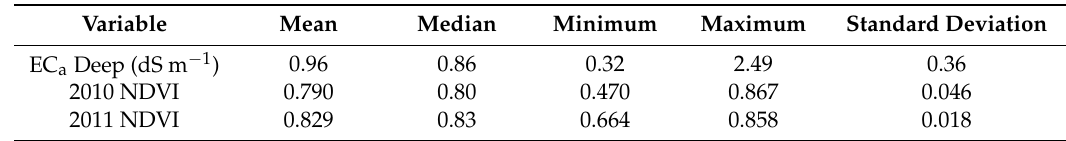
Figure 4. Maps of: ( a ) apparent electrical conductivity of the 0–1.5-m soil profile (EC a Deep); Normalized Difference Vegetation Index (NDVI) for ( b ) 2010 and ( e ) 2011; local geographically-weighted regressions (GWRs) slope coefficient for ( c ) 2010 and ( f ) 2011; and observed versus estimated NDVI relationship for ( d ) 2010 and ( g ) 2011 on significant local GWRs. Table 1. Descriptive statistics for the soil apparent electrical conductivity map (EC a Deep), and the 2010 and 2011 Normalized Difference Vegetation Index (NDVI) maps.